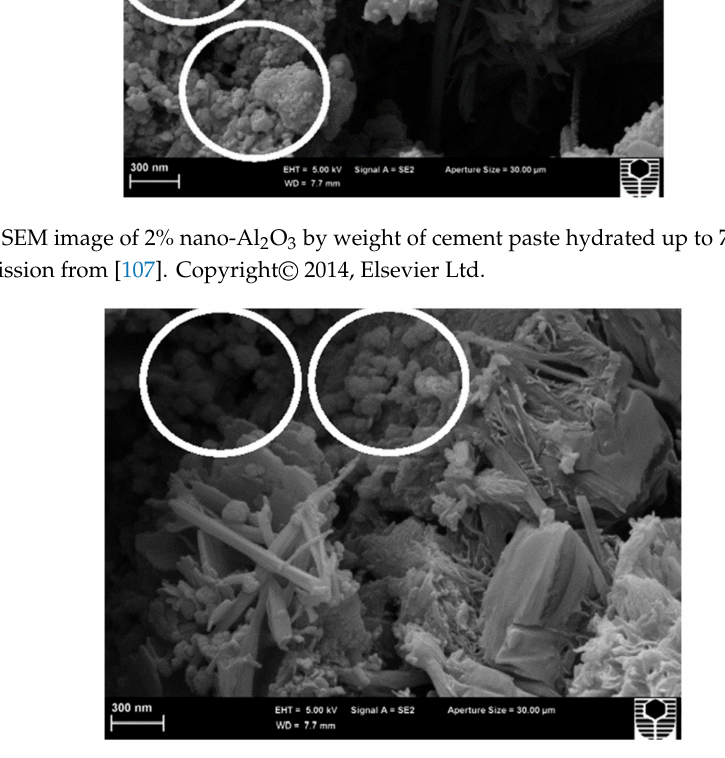
Figure 18. SEM image of 4% nano-Al 2 O 3 by weight of cement paste hydrated up to 7 days. Reprinted with permission from [107]. Copyright © 2014, Elsevier